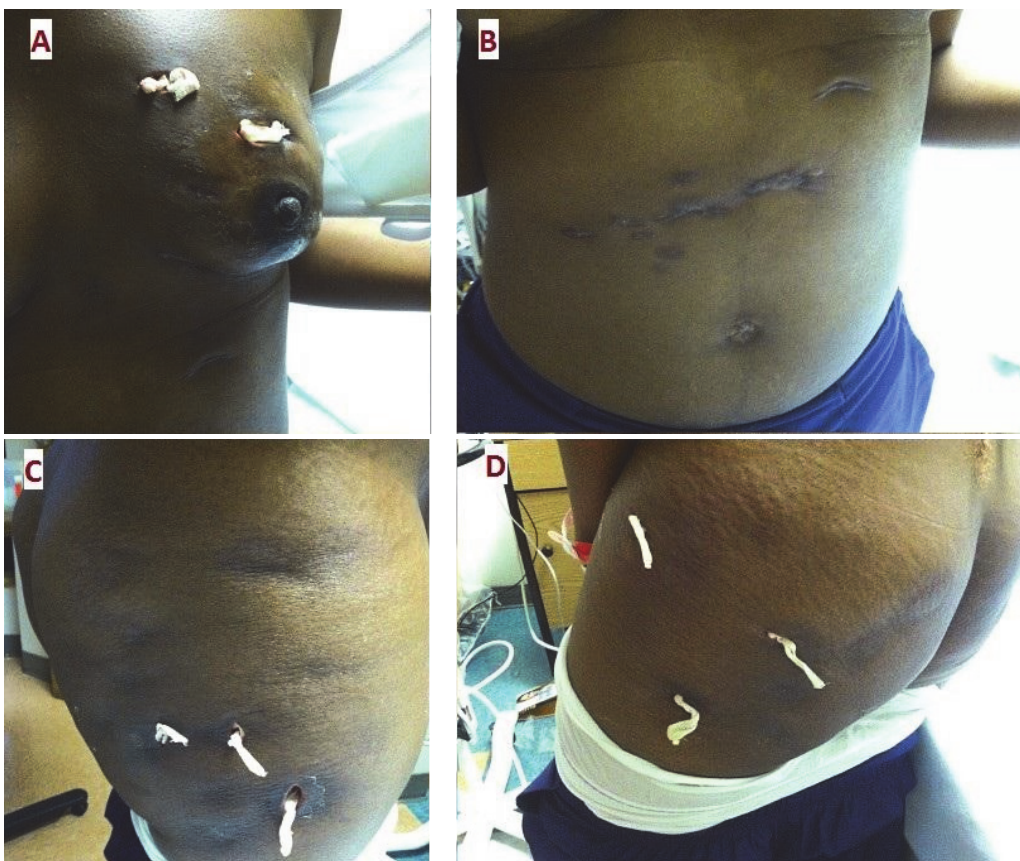
Figure 1: Distribution of skin abscesses. (A) Left breast. (B) Abdomen. (C) Buttocks. (D)